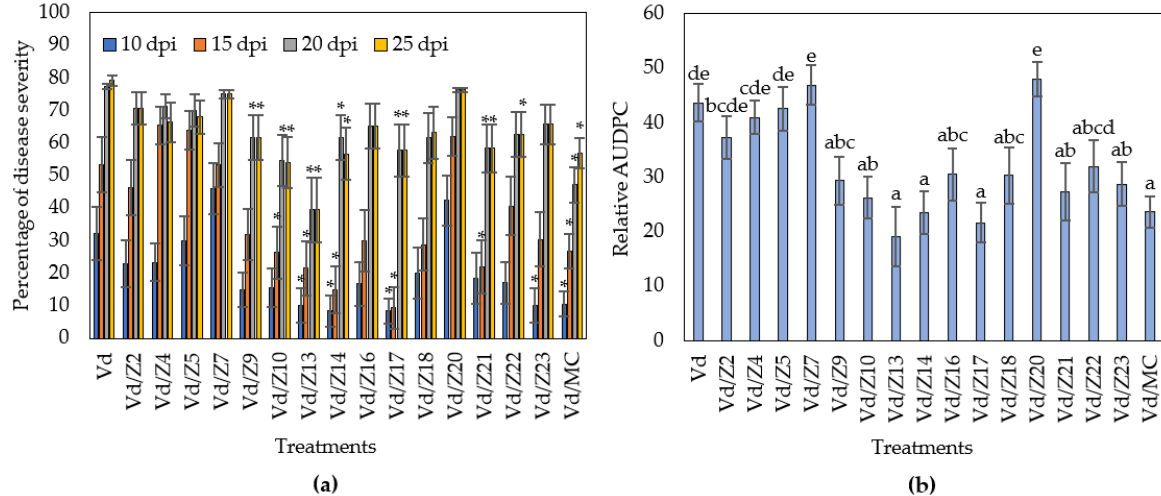
Figure 5. Verticillium disease severity ( a ) and relative AUDPC ( b ) caused by artificial inoculation of V. dahliae (VD), on eggplants treated with microbial strains isolated from the rhizosphere of NB treated eggplants (Z2: Arthrobacter sp .; Z4: Pseudomonas sp .; Z5: Stenotrophomonas sp .; Z7: Pseudomonas sp .; Z9: Enterobacter sp .; Z10: Pseudomonas sp .; Z13: Pseudomonas putida ; Z14: Burkholderia sp .; Z16; Enterobacter sp .; Z17: Burkholderia sp .; Z18: Enterobacter sp .; Z20: Enterobacter sp .; Z21: Burkholderia sp .; Z22: Pantoea sp .; Z23: Pseudomonas sp .; MC: microbial consortium, Z2–Z23). Each treatment consisted of 10 plants and the experiment was repeated three times. Columns represent means of the three replications ( n = 30 plants) and the vertical bars indicate standard errors. For disease severity ( a ), columns with asterisks (*) are significantly different ( p < 0.05) from control (Vd) according to t -test, for each time point; for relative AUDPC ( b ), columns with different letters are significantly different ( p < 0.05) from each other according to LSD test.